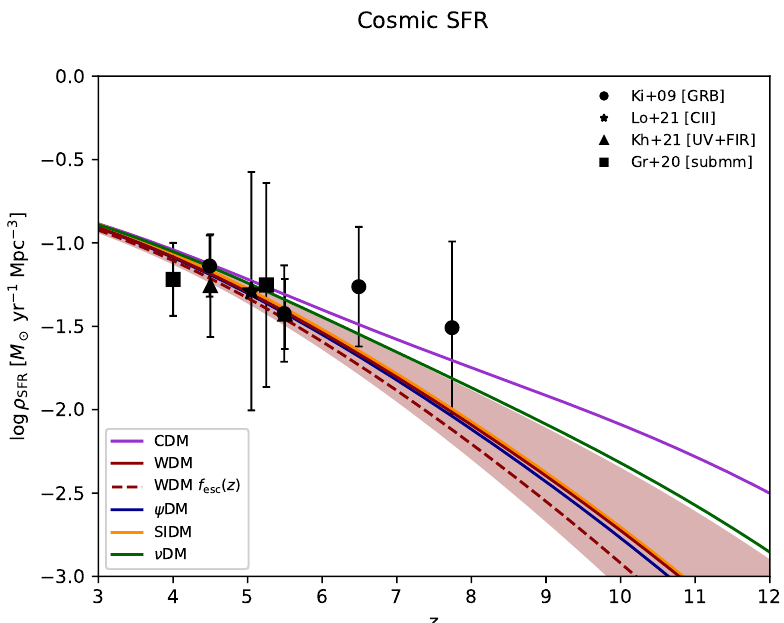
Figure 10. The cosmic SFR density as a function of redshift. Data are from GRBs (circles; see [132]), CII (stars; see [133]), UV+FIR (triangles; see [134]), and (sub)mm (squares; see [135]). Lines illustrate the best fits from the MCMC analysis in various DM scenarios: CDM (purple solid), WDM (red solid), WDM with a redshift-dependent f esc ( z ) (red dashed), ψ DM (blue solid), SIDM (orange solid) and ν DM (green solid). The typical 2 σ credible interval from sampling the posterior distribution is shown, for clarity, only in the WDM scenario, as a red shaded area. Note that the cosmic SFR density has not been fitted upon, since the related measurements have not been exploited in constructing the likelihood of our Bayesian analysis.